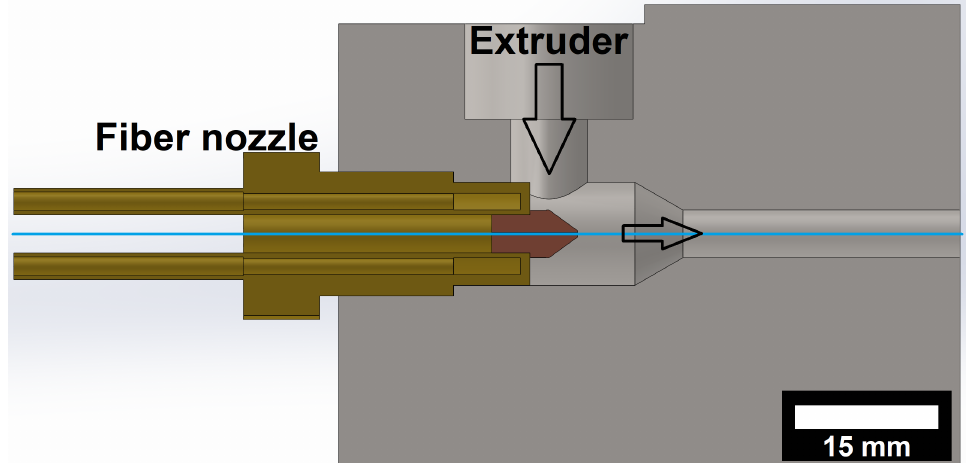
Figure 7. Placement of the nozzle in the extrusion processing machine for the production of future continuous fibre-reinforced polymer